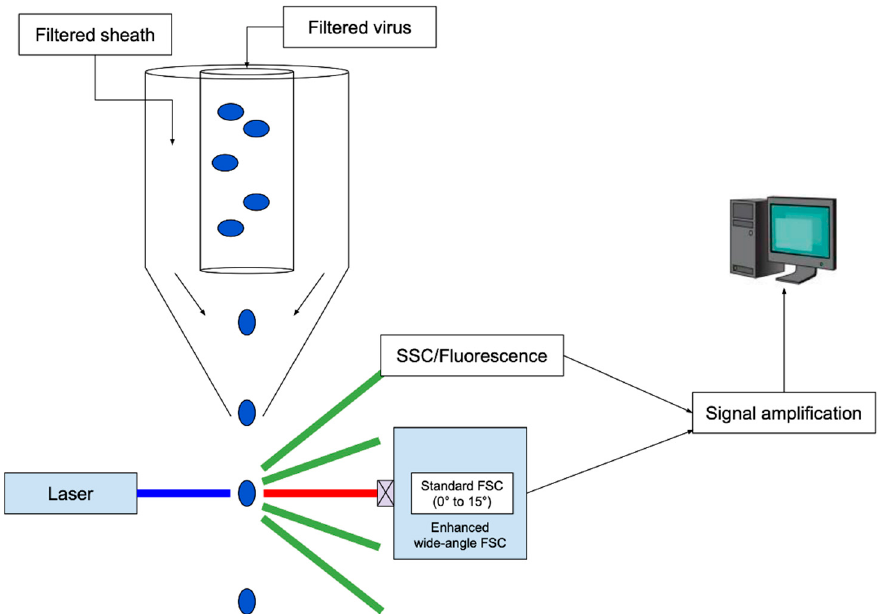
Figure 2. Counting of virus-like particles by flow virometry. The apparatus employs a flow-focusing stream to align particles as they move single file through the beam of a powerful laser, followed by enhanced wide-angle FSC detection. The standard FSC signal used in conventional cell counting is blocked, and the wide-angle FSC signal is enhanced by setting a higher threshold for detection, reducing noise, and thereby enabling sensitive detection of nano-scale particles. Image adapted from [45].